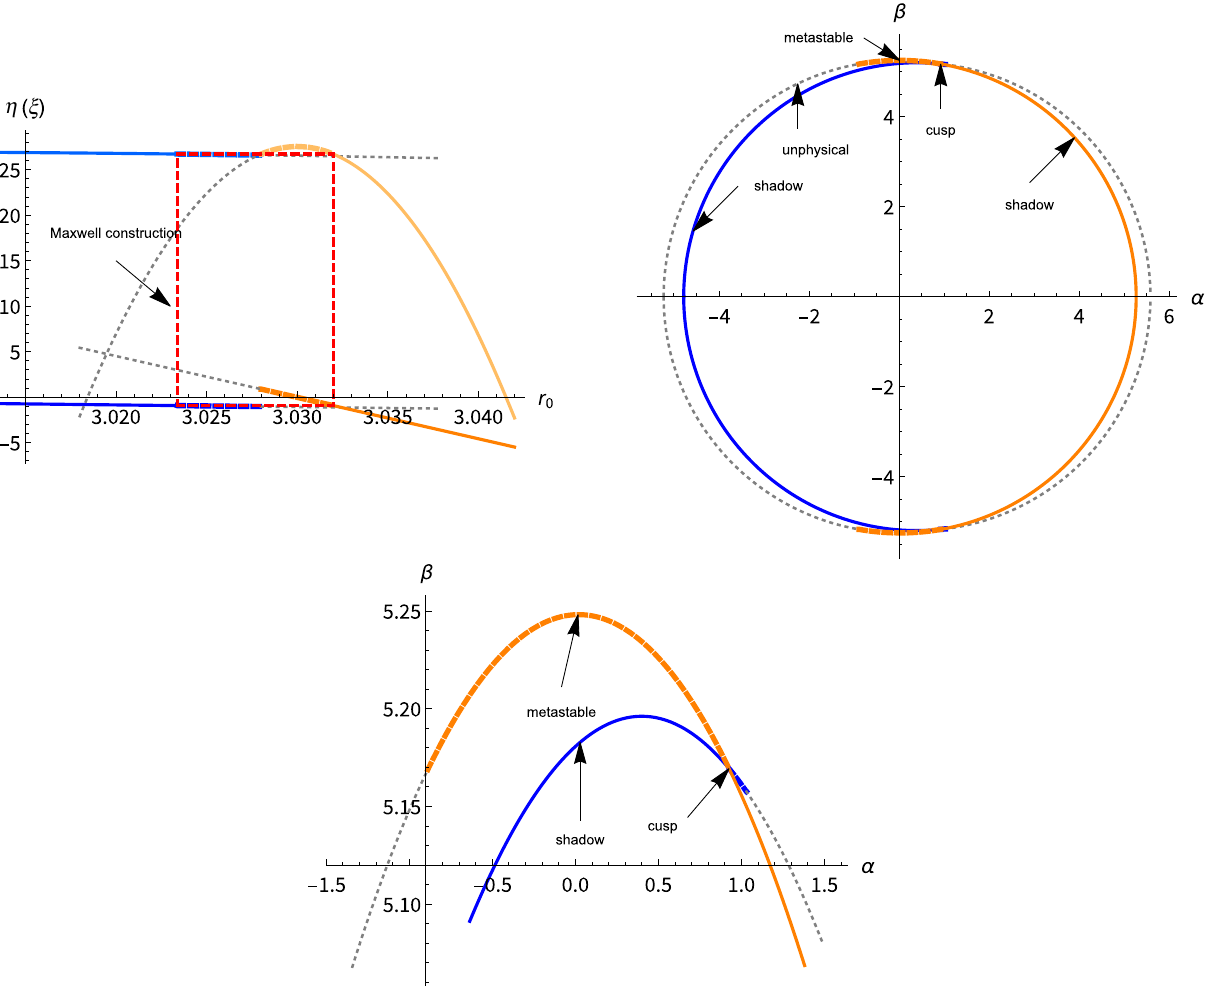
Fig. 1 The Maxwell construction and the corresponding black hole shadow with cusp. The blue curves denote the FPOs associated with the metric for the region r < r sh , while the orange ones are those for the region r > r sh . The solid blue and orange curves (labeled “shadow”) are the collections of FPOs that contribute to the shadow edge. The dashed blue (barely visible) and orange curves (labeled “metastable”) represent those FPOs that do not directly give rise to the shadow edge. The dotted gray curves (labeled “unphysical”) correspond to the FPO solutions that are not physically permitted. Top left: The Maxwell con- struction, shown in the dashed red rectangle, establishes the transition point between the two branches of unstable FPOs in terms of η and ξ